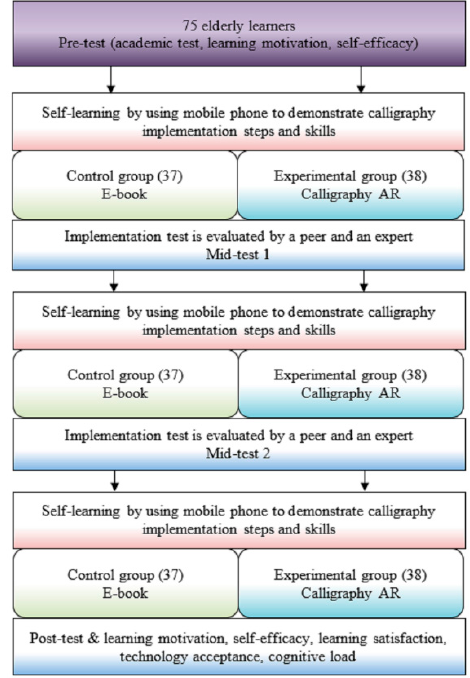
Figure 1. Experimental procedure.